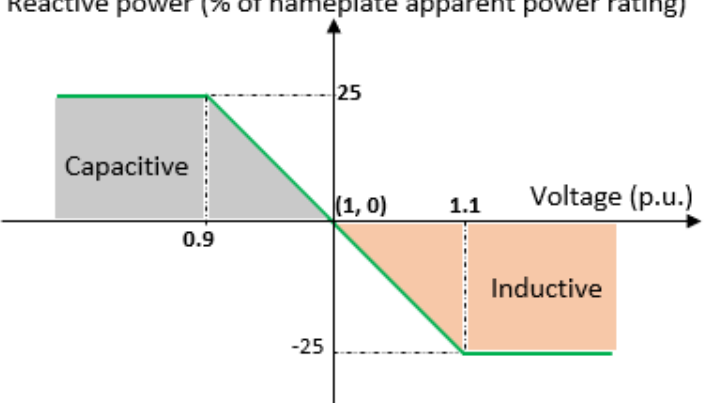
Figure 5. Category A Volt–VAR curve from the IEEE 1547–2018 standard [20] .